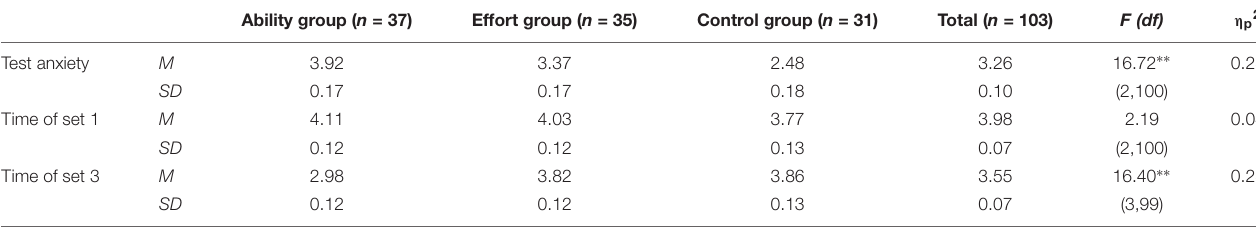
TABLE 3 | Descriptive statistics of claimed and behavioral self-handicapping among children.